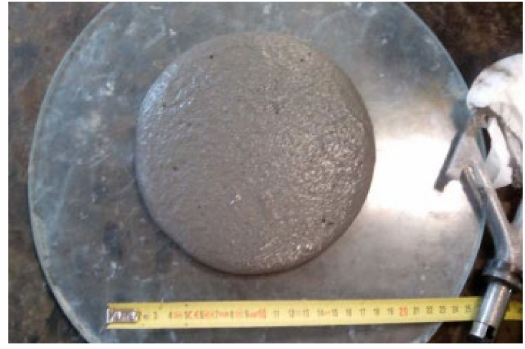
Figure 4. Measurement of the stabilized biscuit. The evolution of the diameter values with time for the three percentages of setting accelerator and the mixture without setting accelerator is represented in Figure 5.